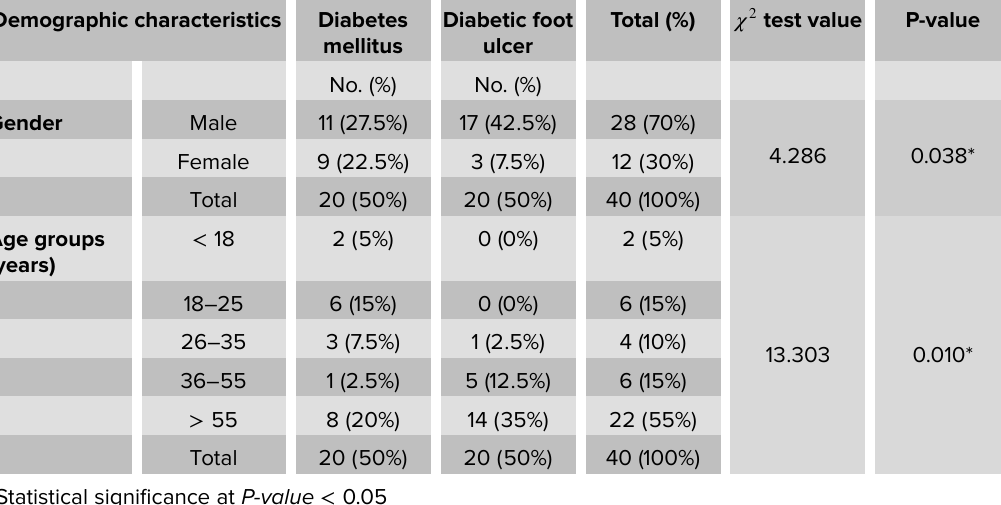
TABLE 1: Frequencies and percentages of diabetic and DFU patients in relation to demographic characteristics